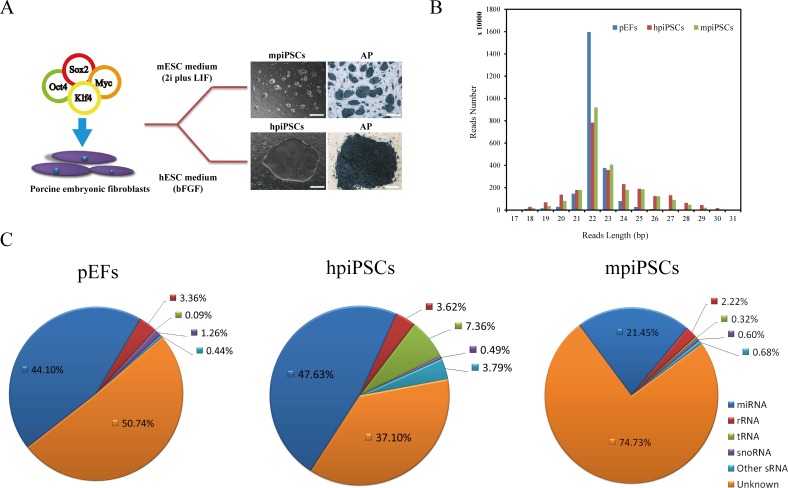
The distribution of small RNA reads and various RNA classes in piPSCs and pEFs.(A) The morphological features and AP staining of piPSCs. Scale bar = 500 μm. (B) The distribution of small RNA reads in the piPSCs and pEFs. (C) Pie chart showing the various RNA classes in pEFs and piPSCs.